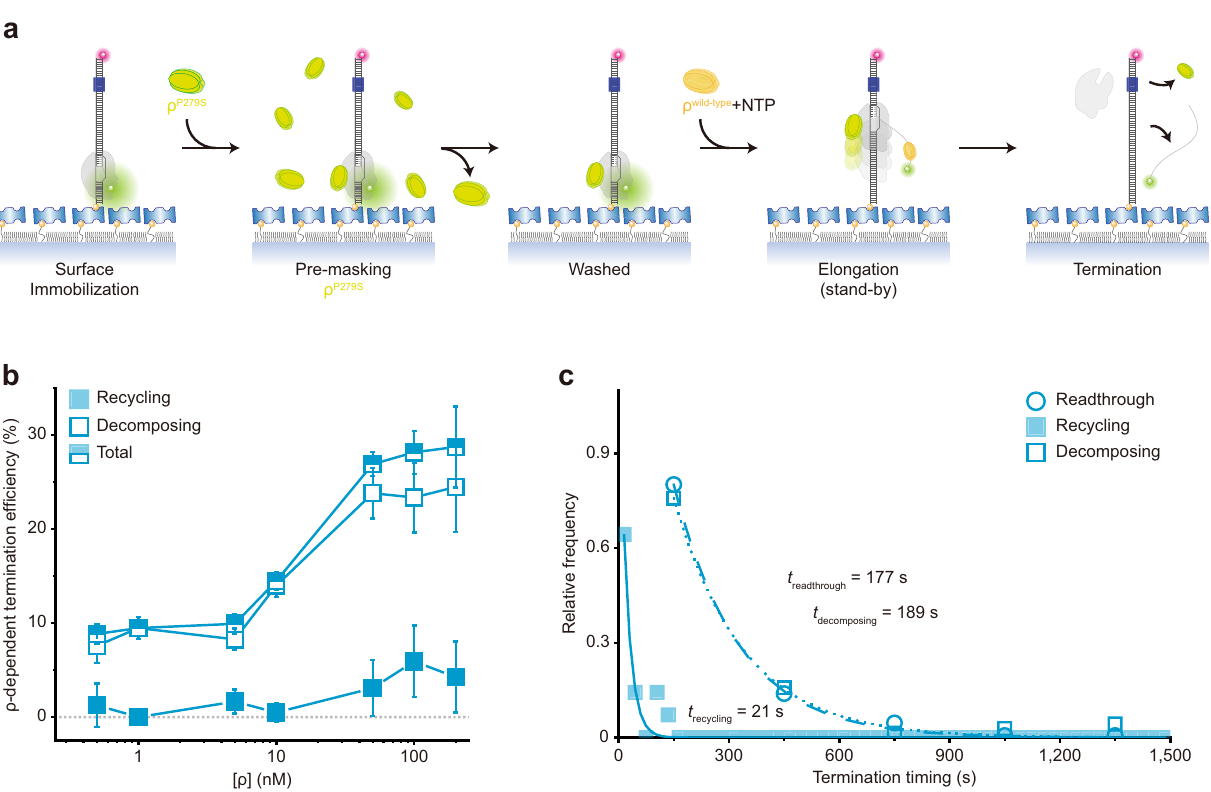
Fig. 3 Catch-up ρ mediating both decomposing and recycling terminations. a Scheme for the catch-up single-molecule assay. Termination is mediated only by catch-up ρ , while an inactive ρ pre-occupies the stand-by site on RNAP and is not replaced by subsequently added wild-type ρ . b ρ -dependency of catch-up recycling and decomposing terminations. The ρ -dependent TEs of recycling (solid) and decomposing (open) in the y -axis are plotted against ρ concentrations on a base-10 log scale in the x -axis. c Relative frequencies of readthrough ( n = 251 complexes), recycling ( n = 14), and decomposing ( n = 70) timings measured in catch-up assays. The data are fi tted to single exponential functions. Error bar represents the standard deviation of the mean from n ≥ 3 independent experiments. The numbers of analyzed molecules for b are in Supplementary Table 2. Source Data fi le includes the data for ( b , c